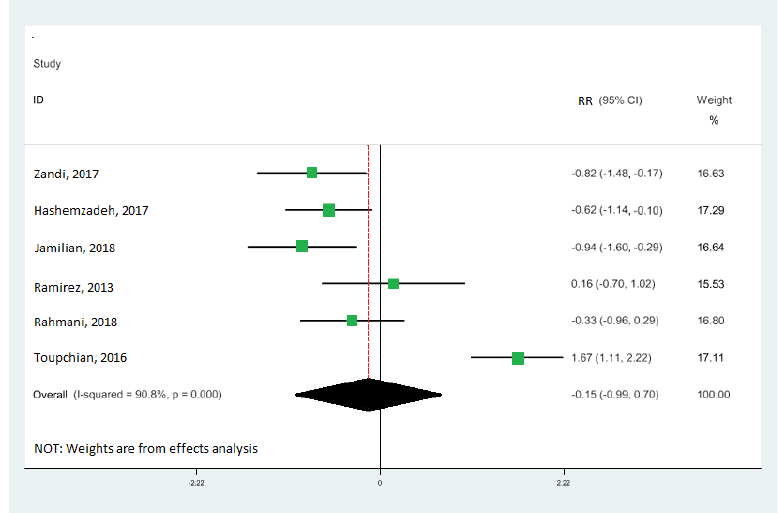
Figure 3. Forest plot of the highest vs. lowest meta-analysis of omega-3 effects on gene expression of inflammation: tumor necrosis factor-alpha (TNF- α ). RR and 95% CI are abbreviations of the relative risk and 95% confidence interval, respectively [19,33,34,36,38,39].